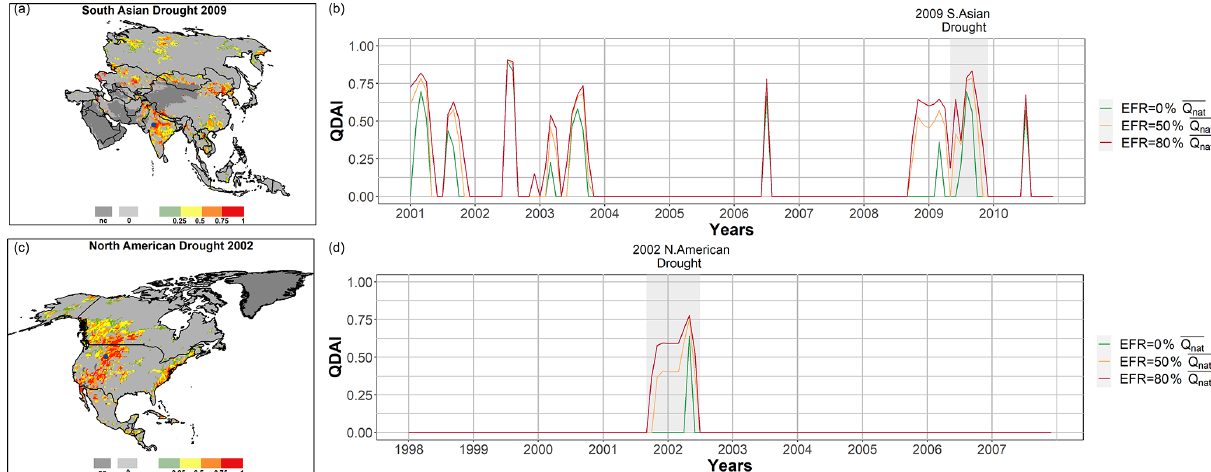
Figure 9. Continental maps of QDAI for Asia and North America for August 2009 and March 2002, respectively (a, c) , with blue points showing the locations of the Indian and US grid cells. Time series of different QDAI with alternative EFR for the Indian grid cell for 2001–2010 (b) and the US grid cell for 1998–2007 (d) . Grid cells which are not computed due to land cover are denoted as